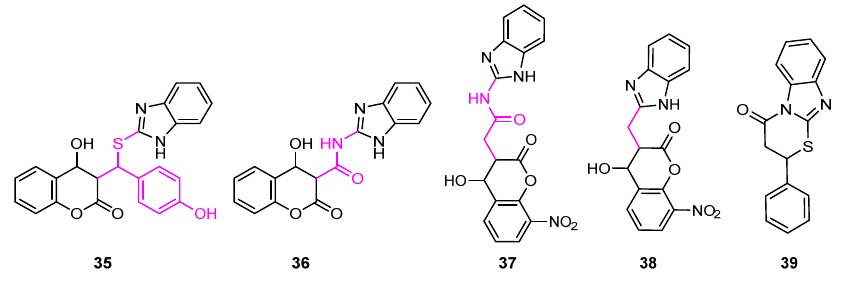
Figure 20. Coumarinebenzimidazole and thiazino [3,2-a] benzimidazol-4-one hybrids structures.